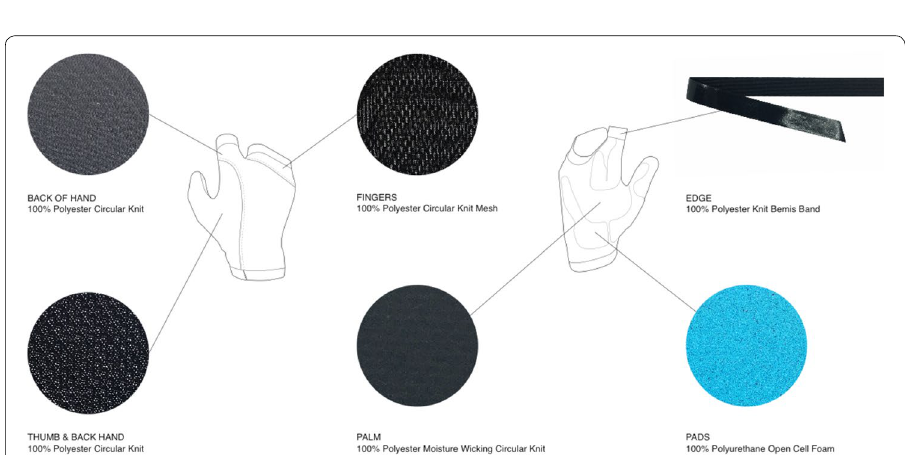
Fig. 15 Cycling glove materials identification (Sokolowski and Hoegsted 2019)